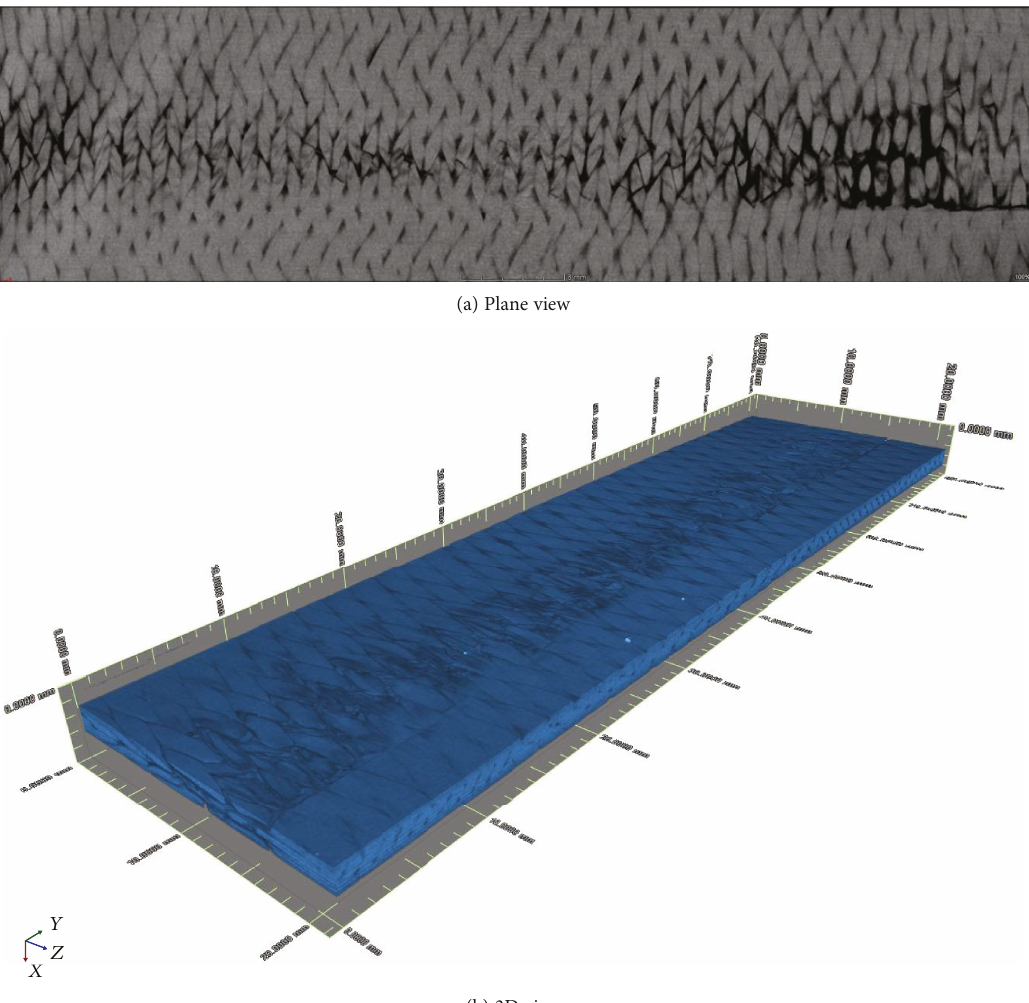
Figure 9: Internal damage at the root of target in test B20-08 after